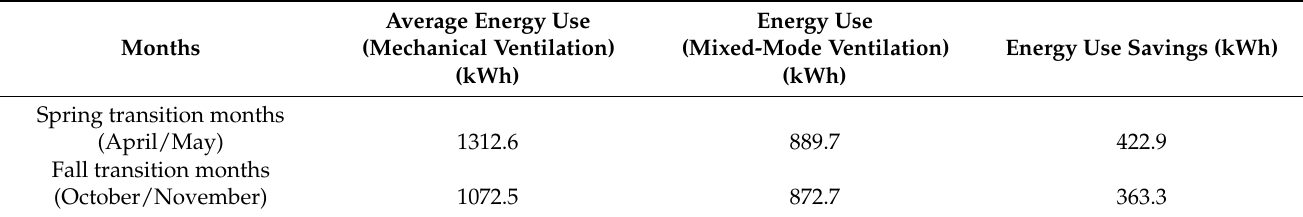
Table 4. HVAC energy use evaluation in a typical